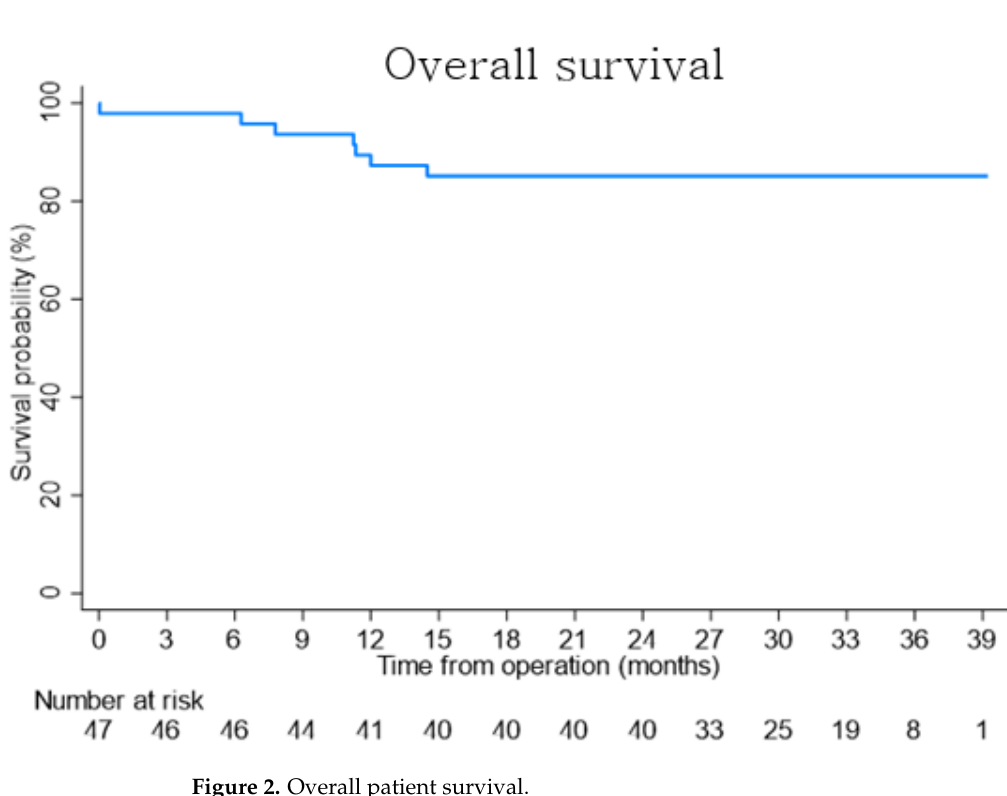
Figure 1. Biliary complication-free patient survival.